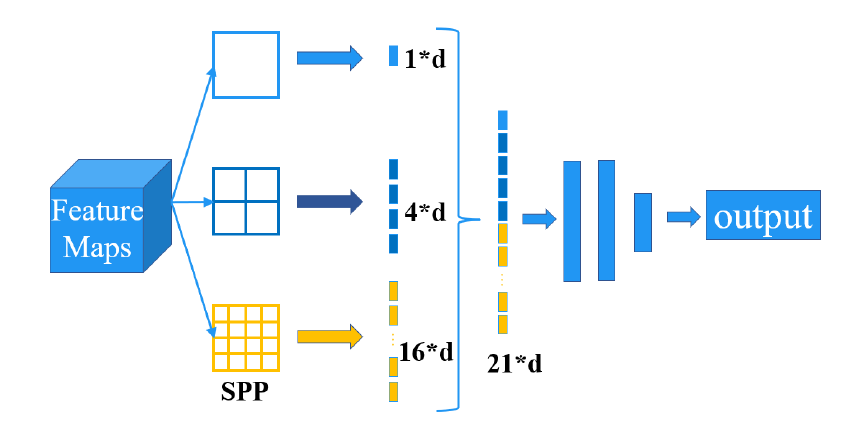
Figure 8. The structure of the SPP-Net. Example of constructing a three-level